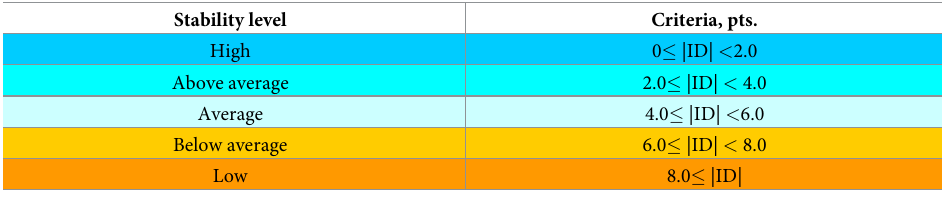
Table 2. Levels of financial stability of OECD+ countries.